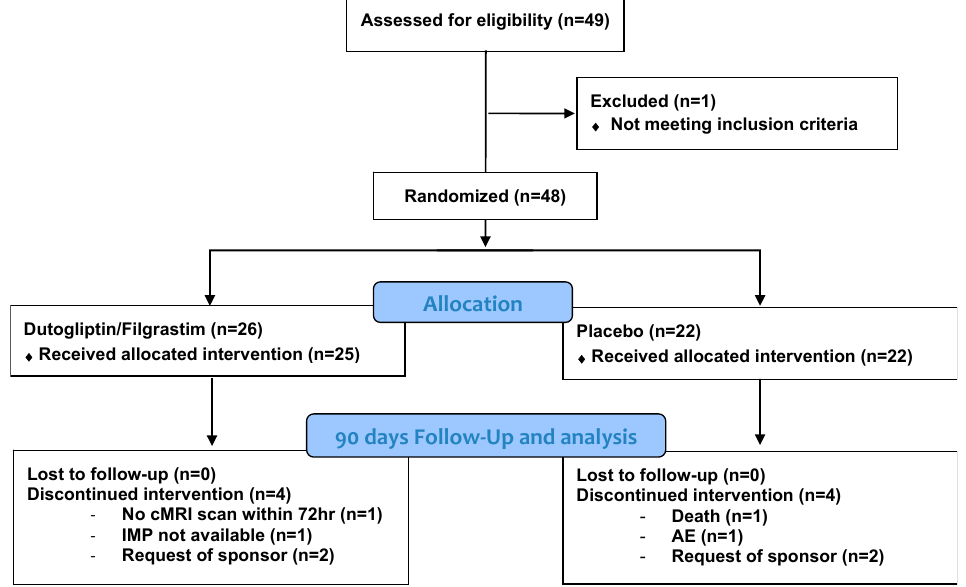
Figure 2. Diagram of patients included in the current study. AE = adverse event, cMRI = cardiac magnetic resonance imaging, IMP = investigational medicinal product. Table 1. Summary of Baseline Characteristics (ITT Population).